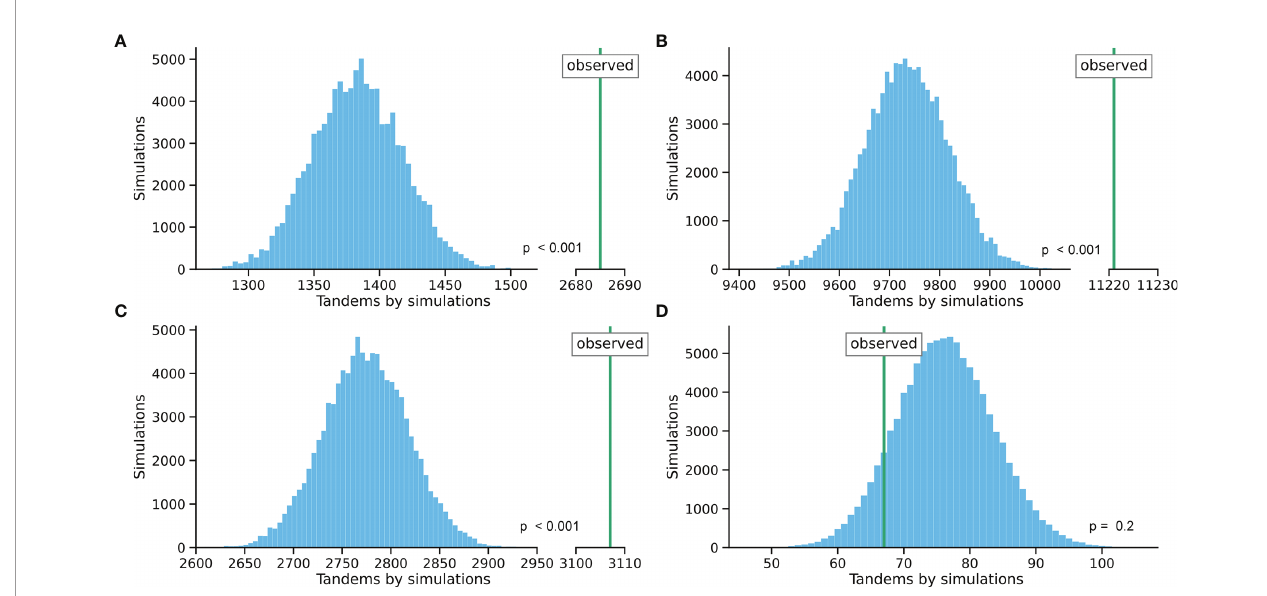
FIGURE 1 | Comparison between the tandems found in the simulated datasets (distribution of 100,000 simulations) and observed values for each cohort. (A) Leiden healthy cohort (IGHV). (B) Rotterdam healthy cohort (IGHV). (C) Rotterdam MSH2/6 de fi ciency cohort (IGHV). (D) Rotterdam UNG de fi ciency cohort (IGHV). The distance between the distribution and the observed value indicates the number of tandem mutations after correction. Z-score analysis was performed to compare